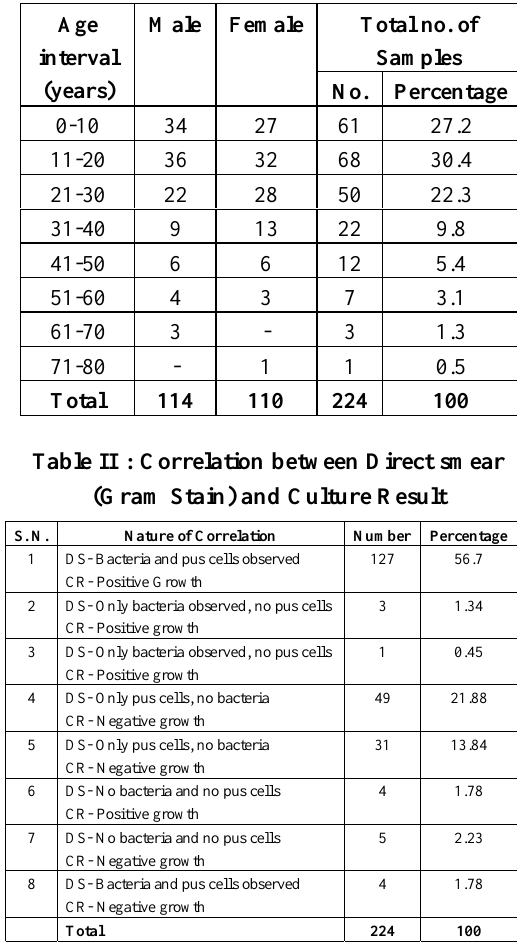
Table I : Agewise and Genderwise